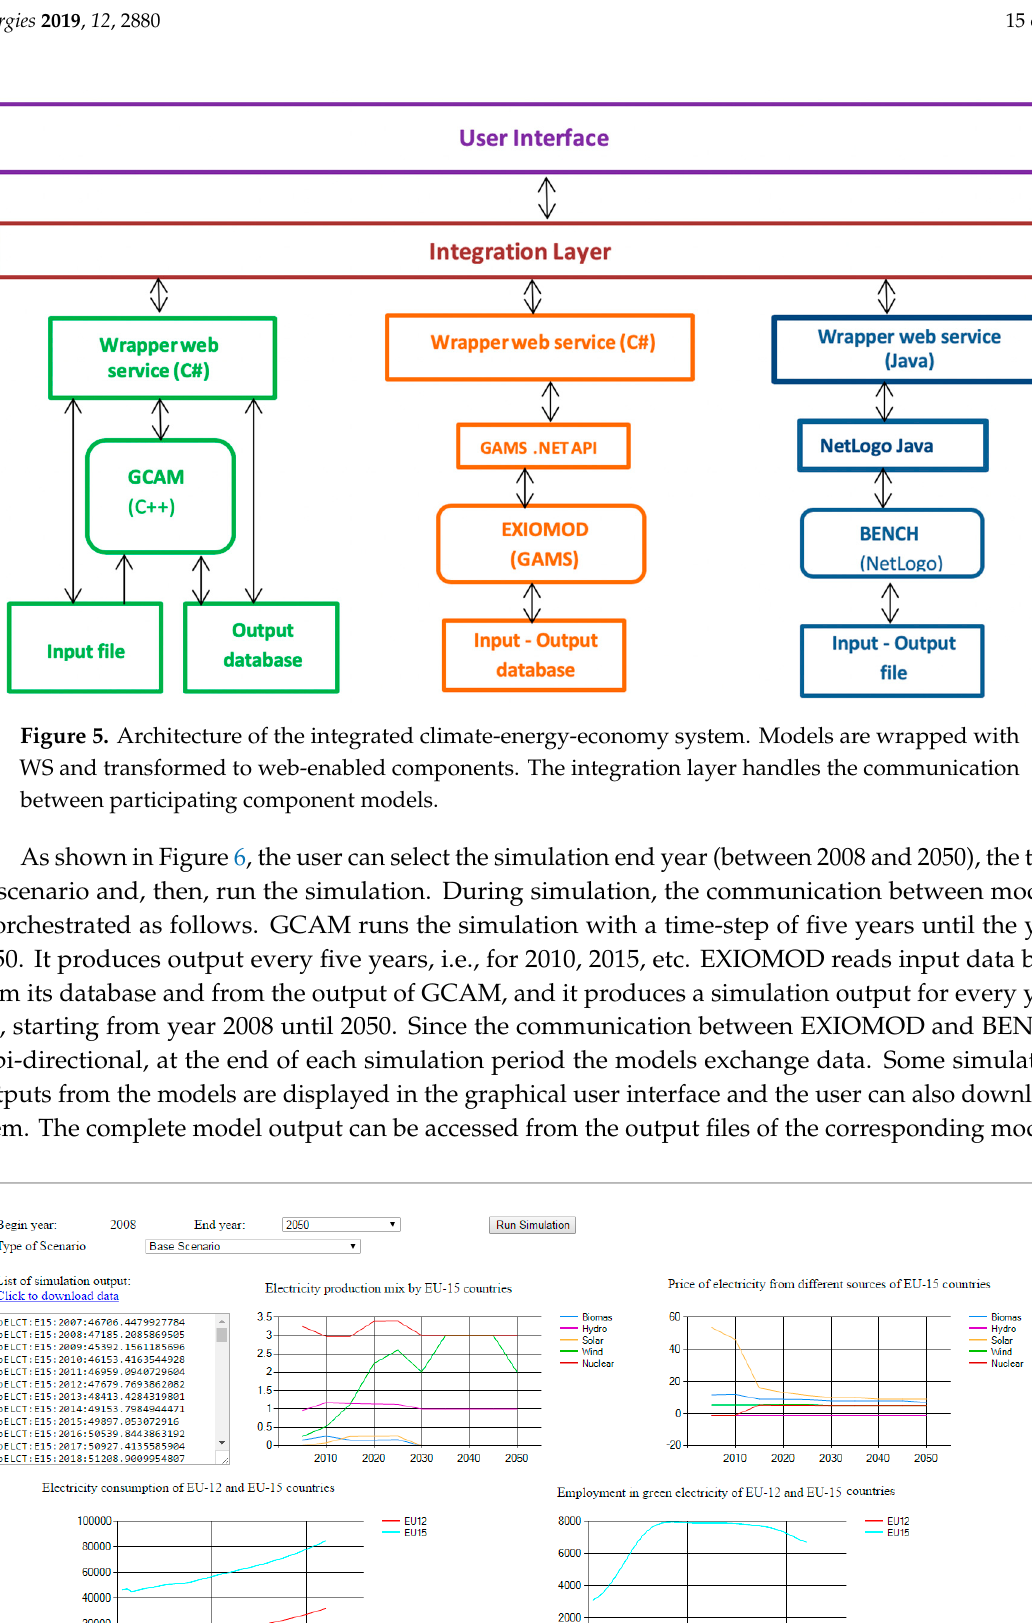
Figure 6. An example of web-based user interface of the integrated system.